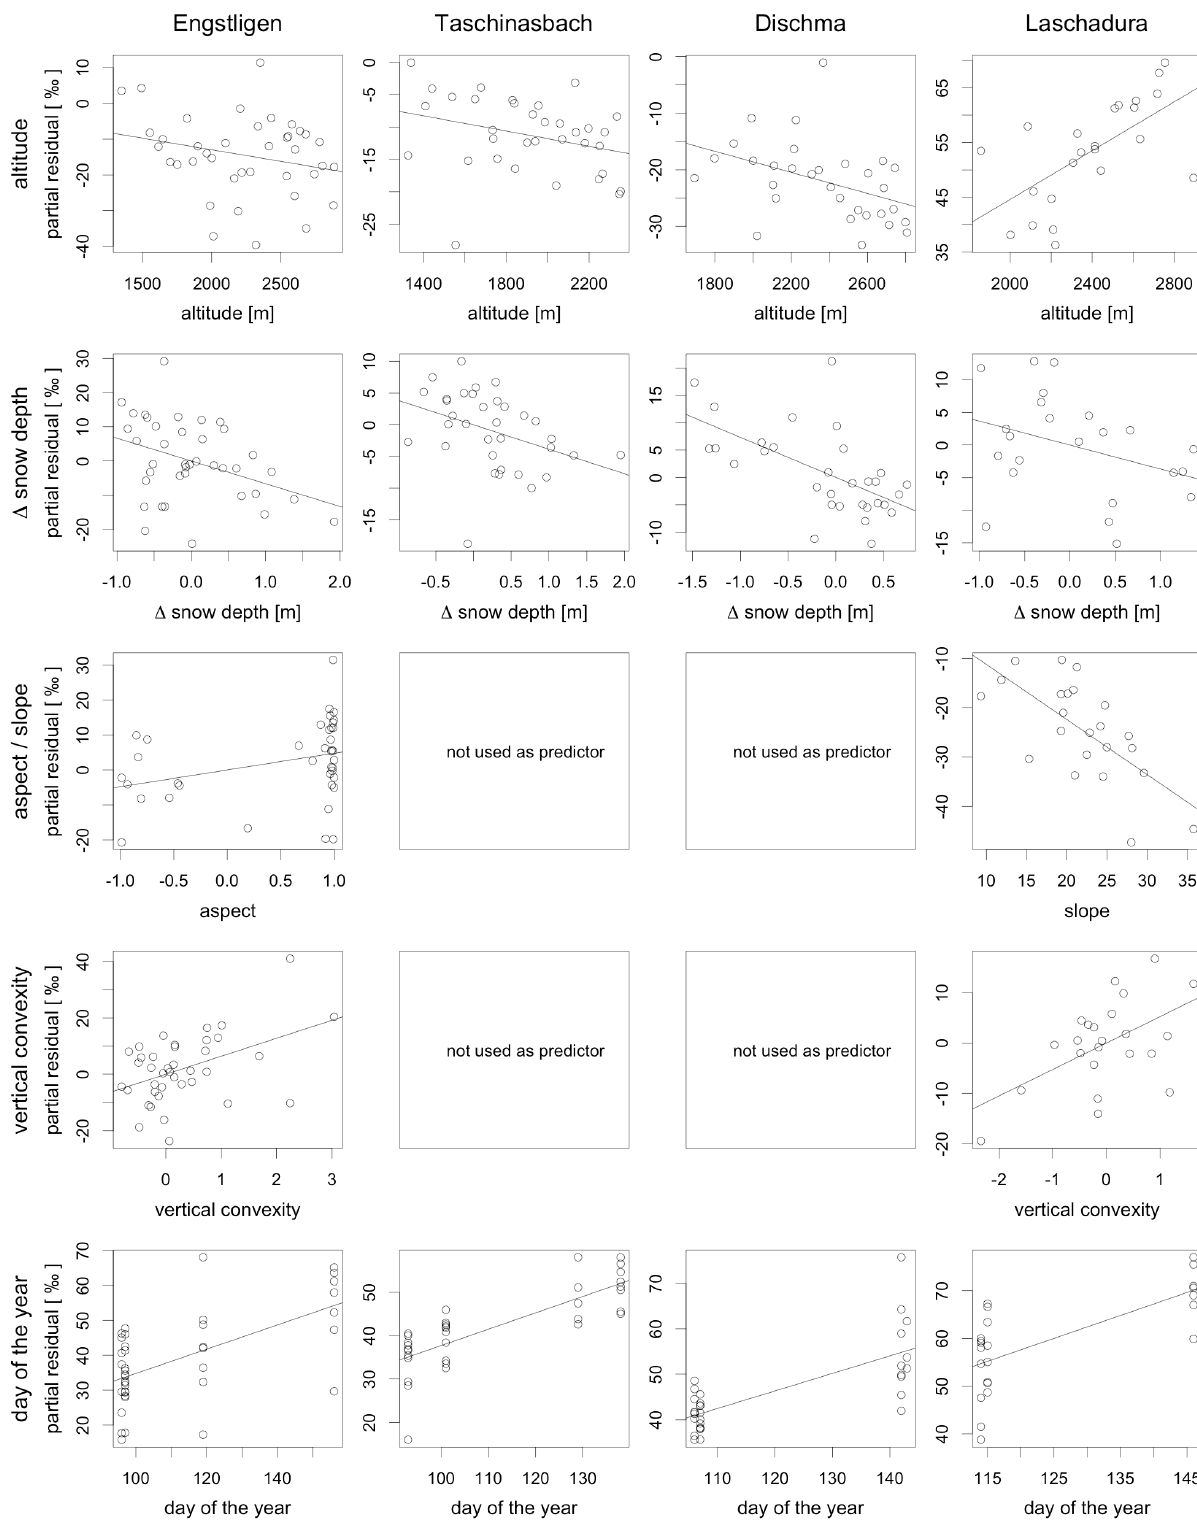
Fig. 5. Partial residuals of each predictor for the four watersheds selected by the stepwise MLR.